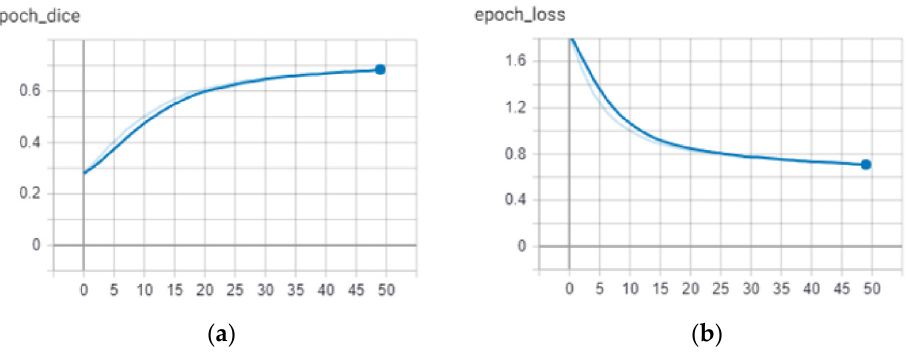
Figure 7. Dice score ( a ) and loss ( b ) of the Adagrad optimizer for the epoch count of 50. (3) Epoch count—50, Optimizer—SGD